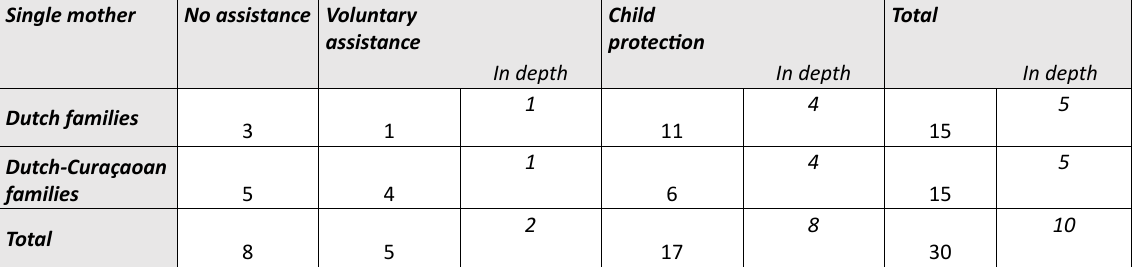
Single-mother families with regard to types of assistance and the depth of the analysis (in italics) Single mother No assistance Voluntary